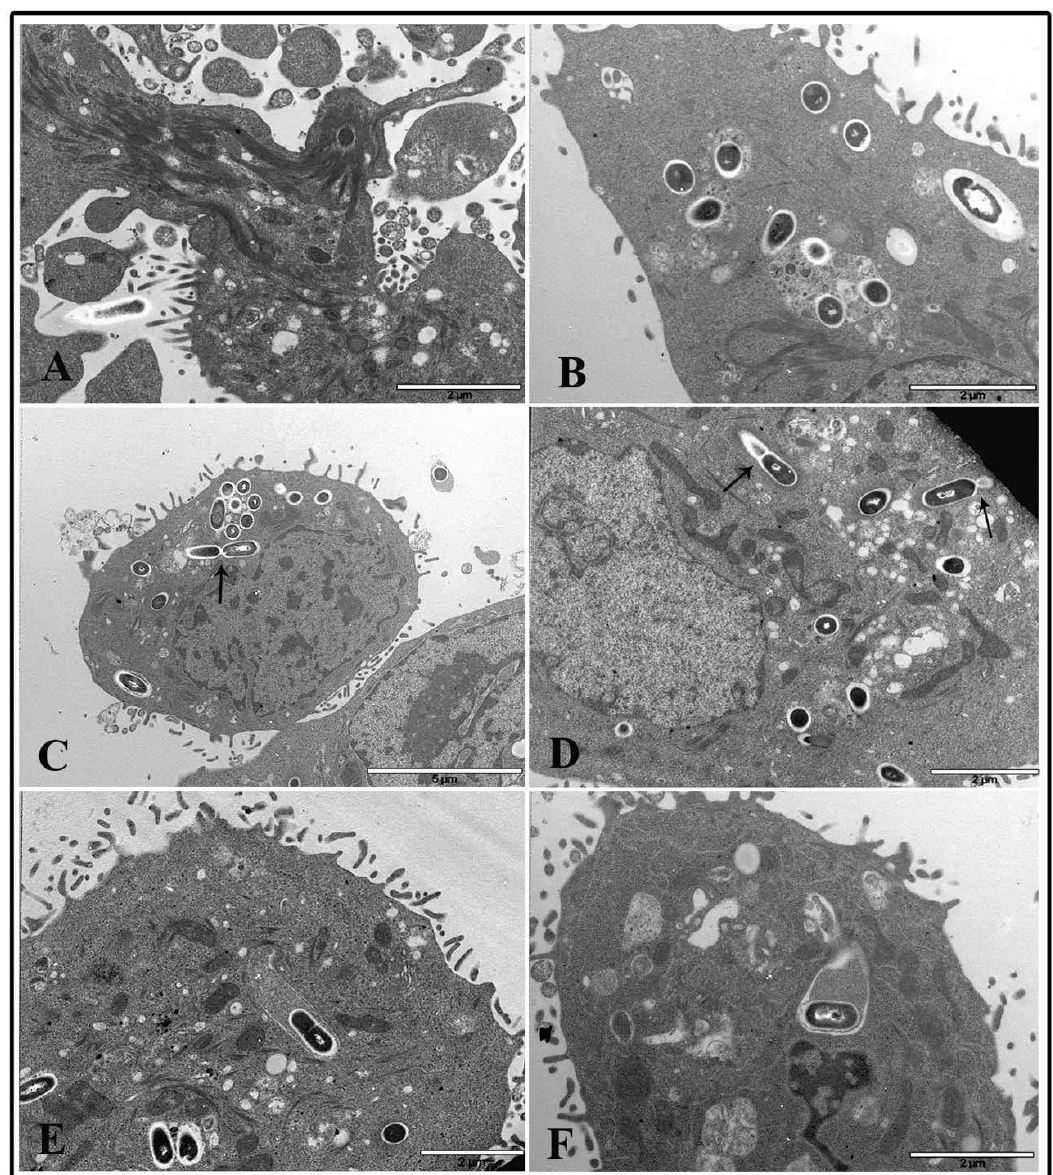
Figure 8. Transmission electron microscopy micrographs of HT-29 cells following exposure to 1 µ g / cm 2 TiO 2 NPs and infected with L. monocytogenes . Representative images of TiO 2 NP pre-treated cells at 2 h ( A , B ) and 6 h ( C – F ).